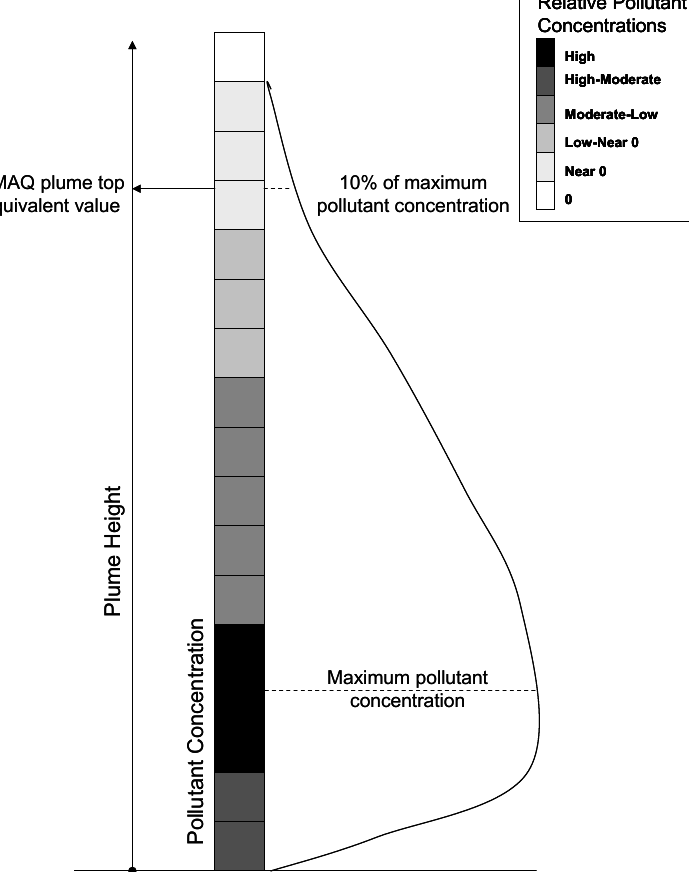
Figure 4. Conceptual illustration of the methodology used to derive the CMAQ plume top